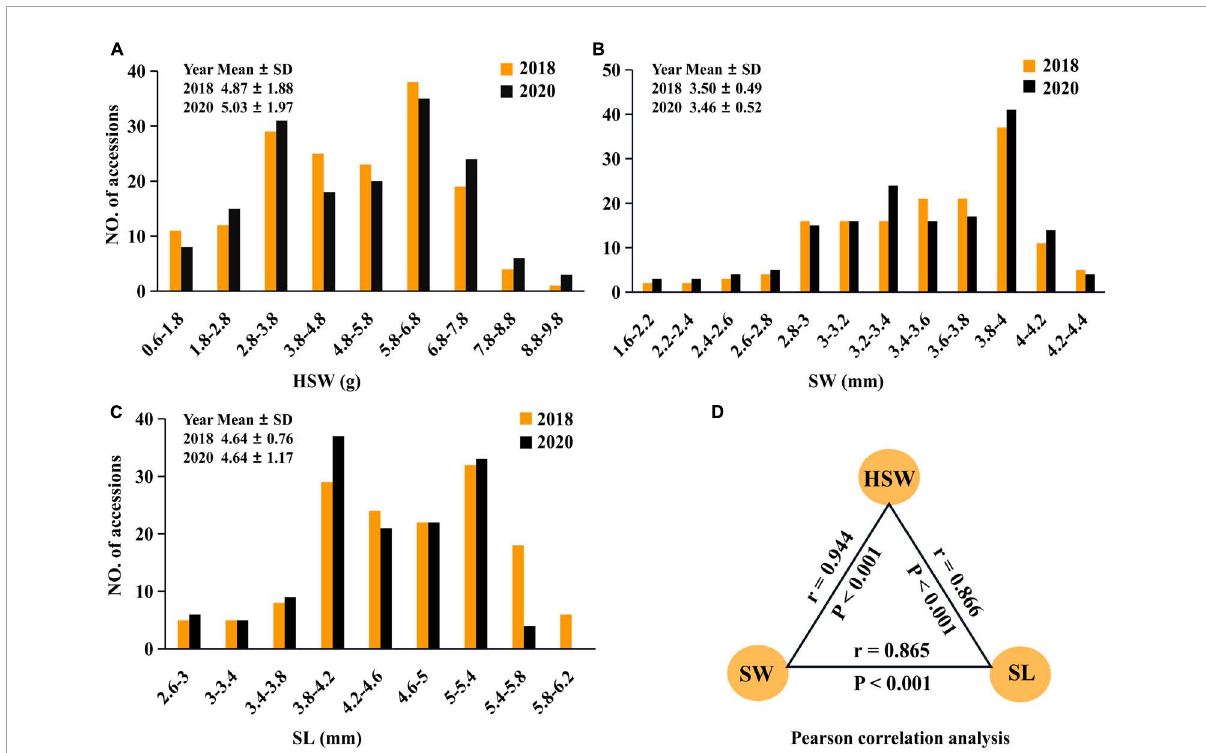
FIGURE1 The frequency distributions of seed-size-related traits. Frequency distributions of HSW (A) (g), SL (B) (mm), and SW (C) (mm) in 196 mungbean accessions, which were measured in 2018 (brown bar) and 2020 (black bar). SD, standard deviation. The associations of HSW with SW and SL, the average dates of those traits measured in 2018 and 2020 were used in the partial correlation analysis (D) .